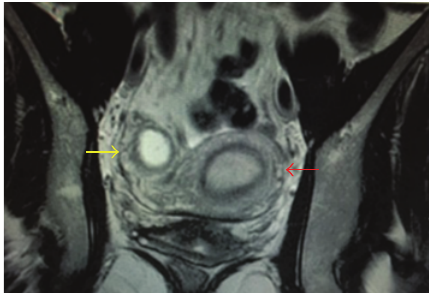
Figure3:MagneticResonanceImaging.Redarrow:leftunicornuate uterus. Yellow arrow: noncommunicating right horn with ectopic pregnancy.